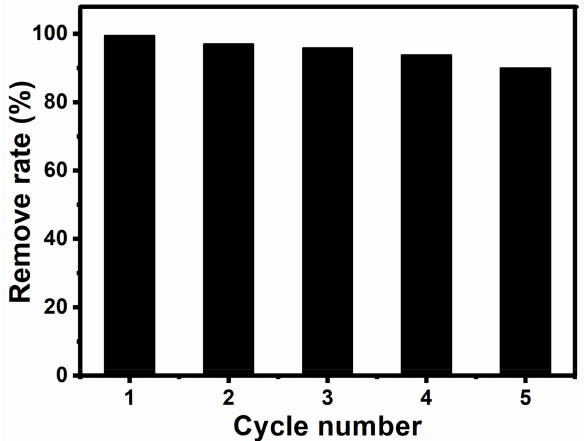
Figure 12. Reusability of Fe 3 O 4 @SiO 2 MNPs as a catalyst for the oxidation of basic fuchsia at the presence of H 2 O 2